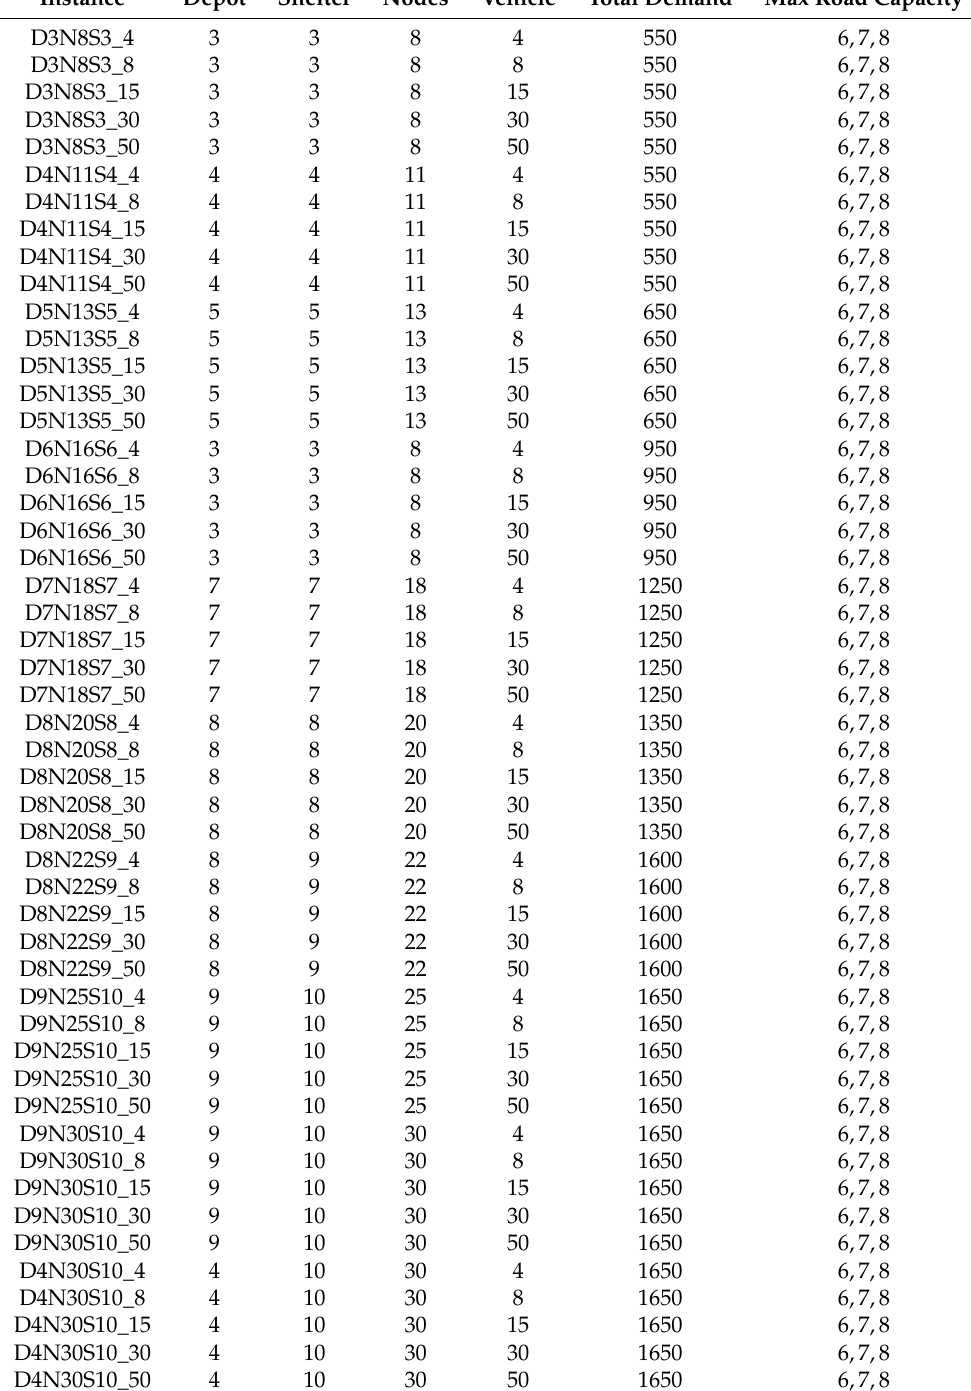
Table 3. Simulated test instances applied to validate the model and solutions